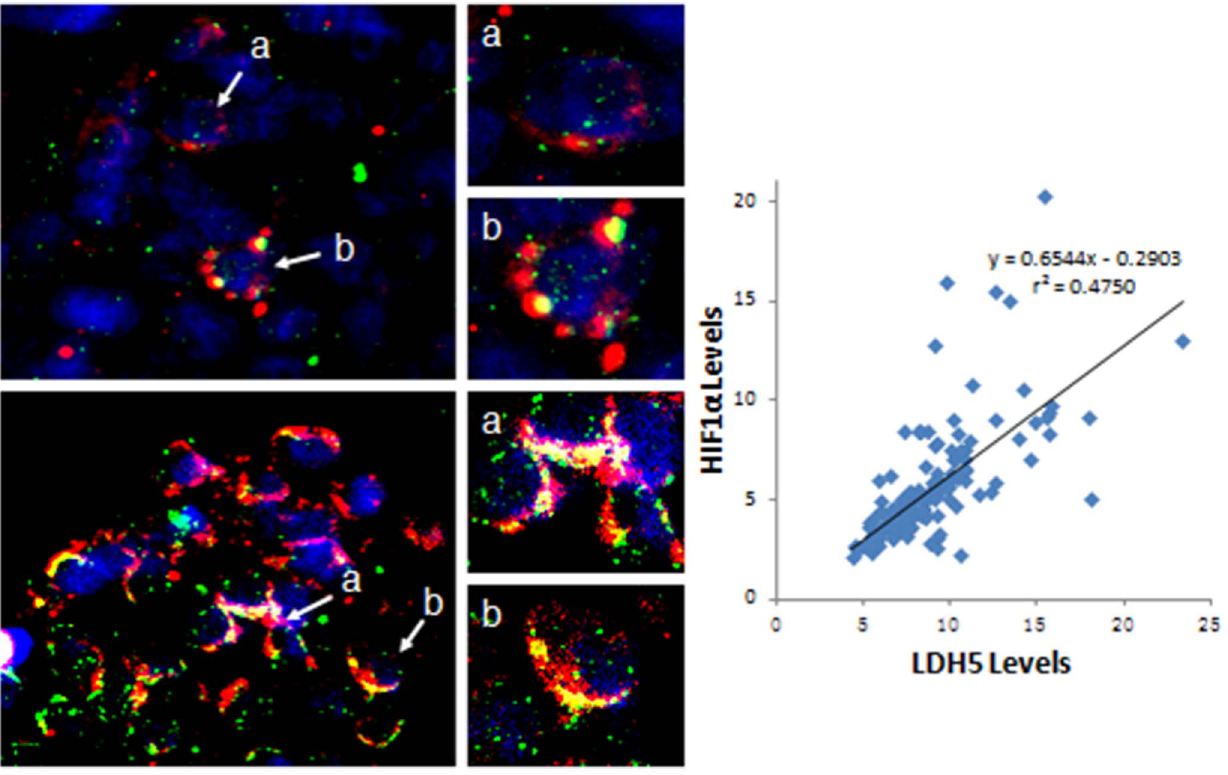
Figure 4. Immunofluorescence staining for the expression of LDH-5 and HIF1 a in malignant NHL and benign lymphadenectasis tissues. (A) Colocalization of LDH-5 (green) and HIF1 a (red) in benign lymphadenectasis (nuclear staining, blue); (B) Colocalization of LDH-5 (green) and HIF1 a (red) in malignant NHL (nuclear staining, blue); (C) The correlation of serum LDH-5 and HIF1 a expression in peripheral blood of the participants ( n =160) including the patients with NHL ( n =130) and Non-NHL controls ( n =30).